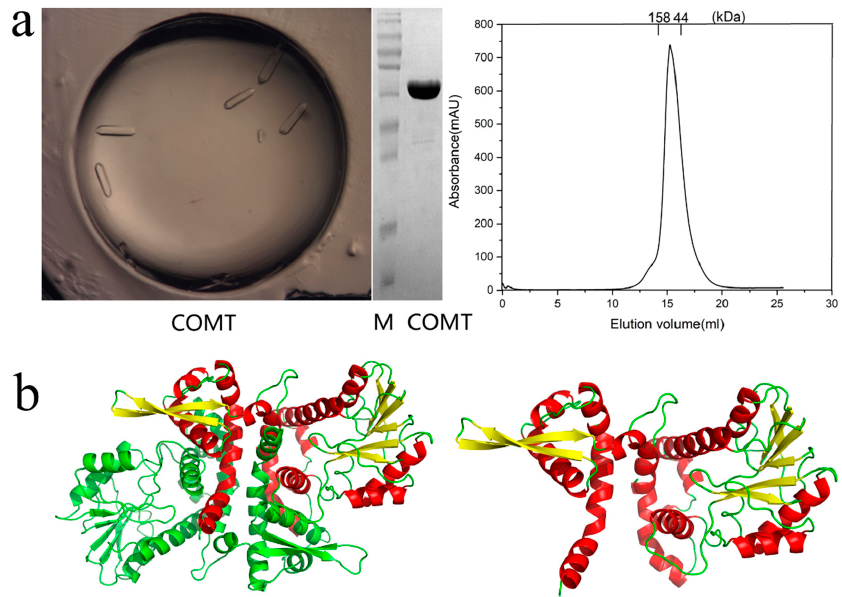
Figure 3. Crystallization, SDS-PAGE, and elution volume analysis of purified COMT-S protein ( a ) and its apo form crystal structure ( b ). M, the molecular mass of the ladder, indicated 100, 70, 55, 40, 35, and 25 kDa from top to bottom. Int. J. Mol. Sci. 2019 , 20 , x FOR PEER REVIEW